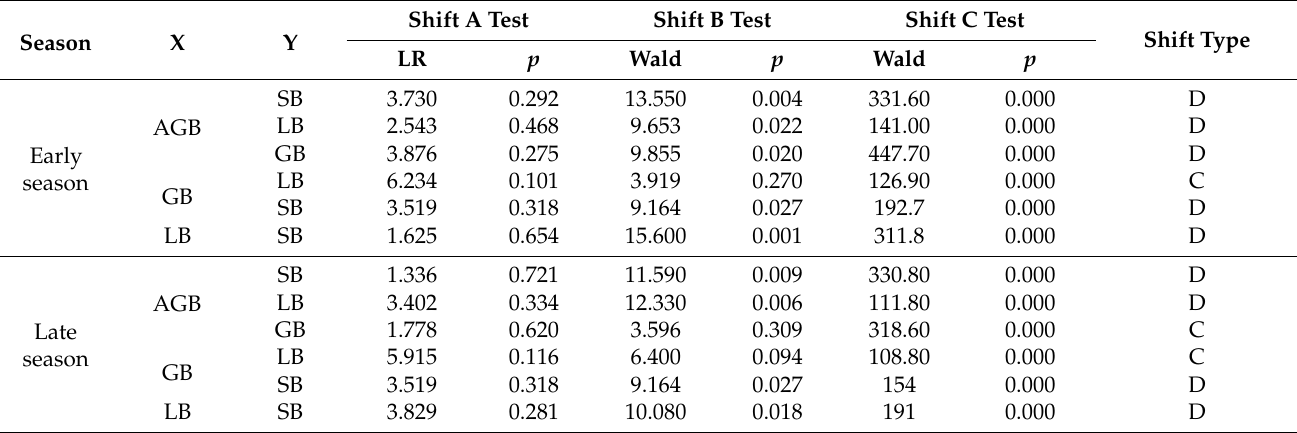
Table 6. Common slope test and allometric relationship and drift type of above-ground organ biomass in different treatments of